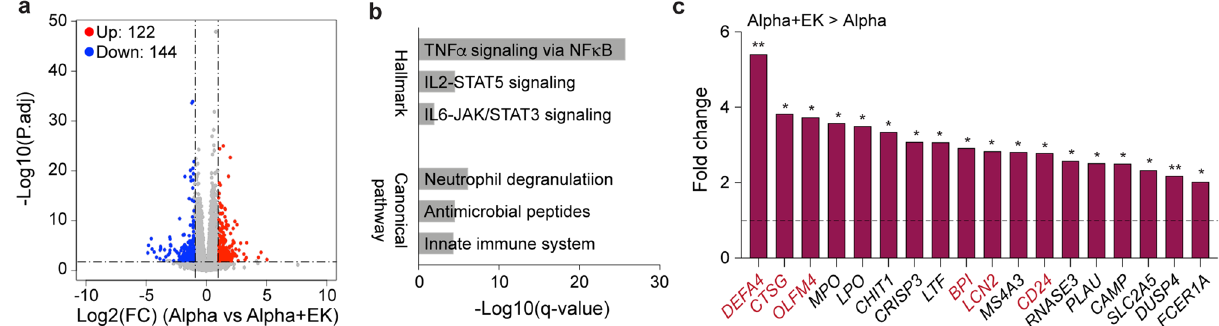
Figure 3. Differences of immune response between hospitalized patients infected with the Alpha or Alpha + EK variant. ( a ) The volcano plot shows the DEGs between the Alpha and Alpha + EK patients. The numbers of upregulated and downregulated genes are listed. ( b ) Hallmark and Canonical pathway analysis of significantly enriched genes included in clusters for innate immune-related biological processes. ( c ) Relative mRNA levels of 18 immune associated genes that are induced in the Alpha + EK patients as compared to the Alpha patients and enriched in innate immune response are presented by bar graphs. The genes of neutrophil degranulation are shown in red. DESeq2 p -adj from wald test using Benjamini and Hochberg method are listed in Supplementary Table 4. * p < 0.05, ** p <